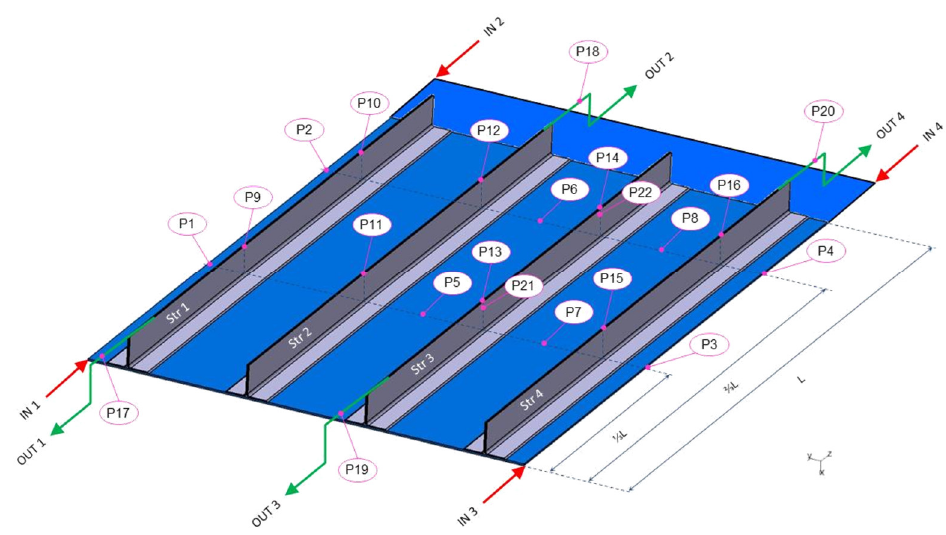
Figure 3. Illustration of the effective position of the whole fiber optic sensor network.